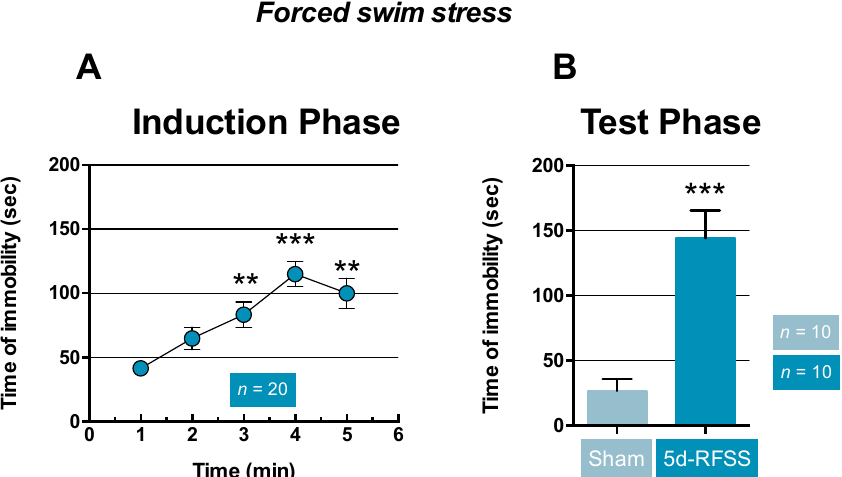
Figure 1. Effects of 5d-RFSS on time of immobility in C57BL/6J mice. ( A ) Data are means ± standard error of the mean (SEM) of time of immobility (sec) in the forced-swim tests (FST) during the induction phase (days 1–5). Statistical analysis: one-way ANOVA with repeated measures indicated significant effects of time (F(4,76) = 13.5; p < 0.001). ** p < 0.01 and *** p < 0.001: significantly different from D1 ( n = 20) using Fischer’s PLSD post-hoc test. ( B ) Data are means ± SEM of time of immobility time (s) during the test phase in 5d-RFSS mice and their controls (sham) that were not subjected to forced swim during the induction phase. Statistical analysis: Student’s t -test, t1, 18 = 5.34. *** p < 0.001: significantly different from control non-stressed mice (sham). n = 10 mice per group.